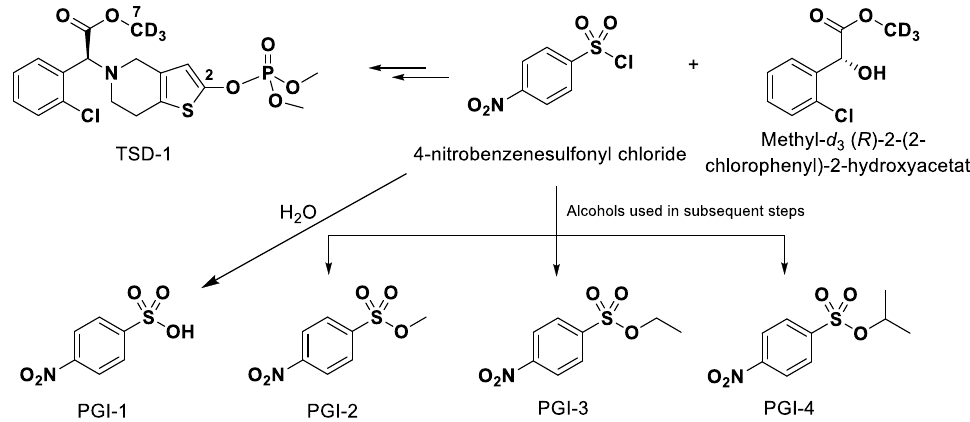
Figure 1. Synthetic route of TSD-1. Reagents and conditions: (a) methanol- d 4 , H 2 SO 4 , reflux; (b) DMAP, CH 2 Cl 2 , Et 3 N, − 10 ◦ C to − 5 ◦ C; (c) K 2 CO 3 , acetonitrile, r.t.; (d) dimethyl chlorophosphate, THF, DBU, − 15 ◦ C to − 10 ◦ C.